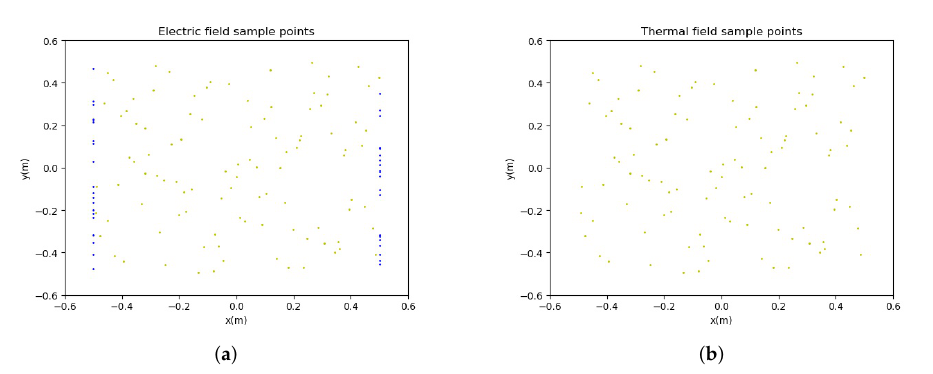
Figure 4. Sample points: ( a ) for the electric field problem; ( b ) for the thermal field